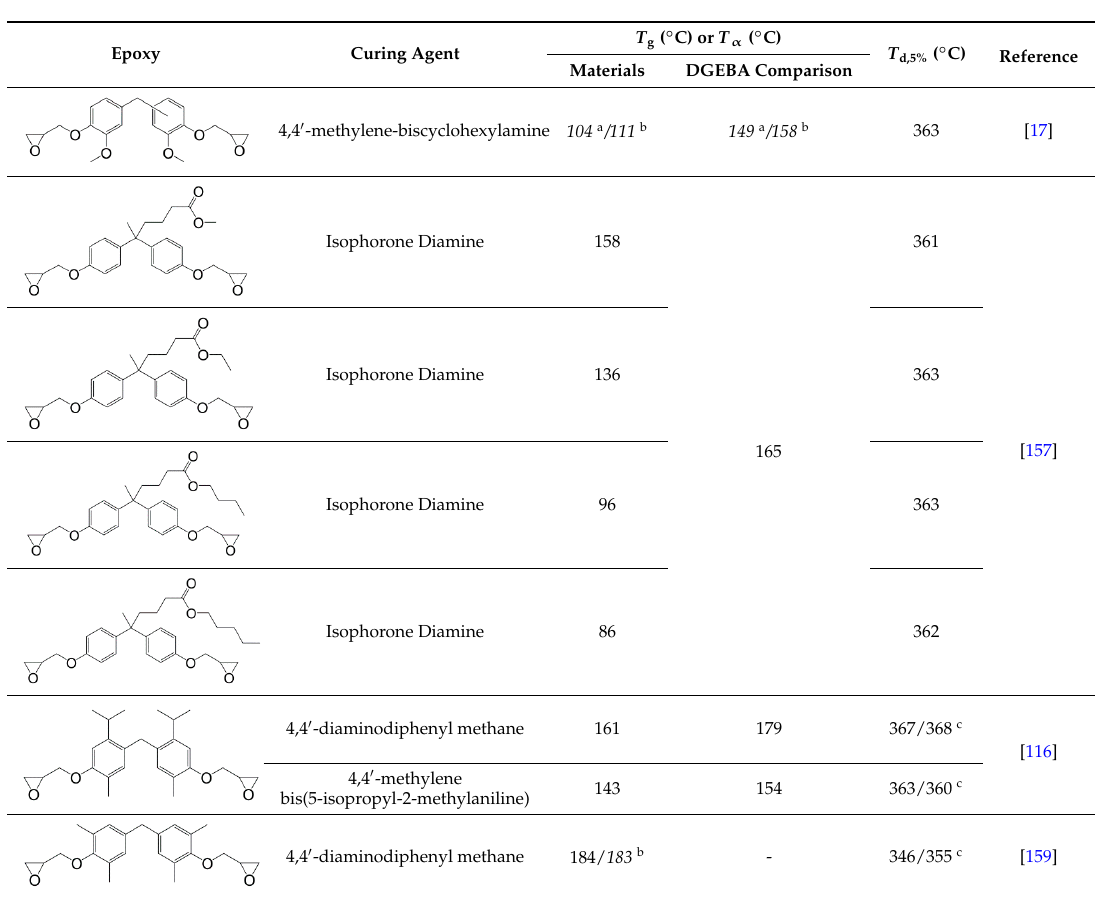
a T α measured by DMA at the peak position of loss modulus curve; b T α measured by DMA at the maximum of tan δ ; c T d under air flow. Table 3. Di-epoxy resins with two aromatic rings separated by one atom, and thermal properties of the Table 3. Di-epoxy resins with two aromatic rings separated by one atom, and thermal properties of the Table 3. Di-epoxy resins with two aromatic rings separated by one atom, and thermal properties of the Table 3. Di-epoxy resins with two aromatic rings separated by one atom, and thermal properties of the maximum of tan δ ; c T d under air flow. Table 3. Di-epoxy resins with two aromatic rings separated by one atom, and thermal properties of the Table 3. Di-epoxy resins with two aromatic rings separated by one atom, and thermal properties of the cured materials. cured materials. cured materials. Table 3. Di-epoxy resins with two aromatic rings separated by one atom, and thermal properties of the cured materials. cured materials. cured materials. Table 3. Di-epoxy resins with two aromatic rings separated by one atom, and thermal properties of the Table 3. Di-epoxy resins with two aromatic rings separated by one atom, and thermal properties of the cured materials. cured materials. cured materials.